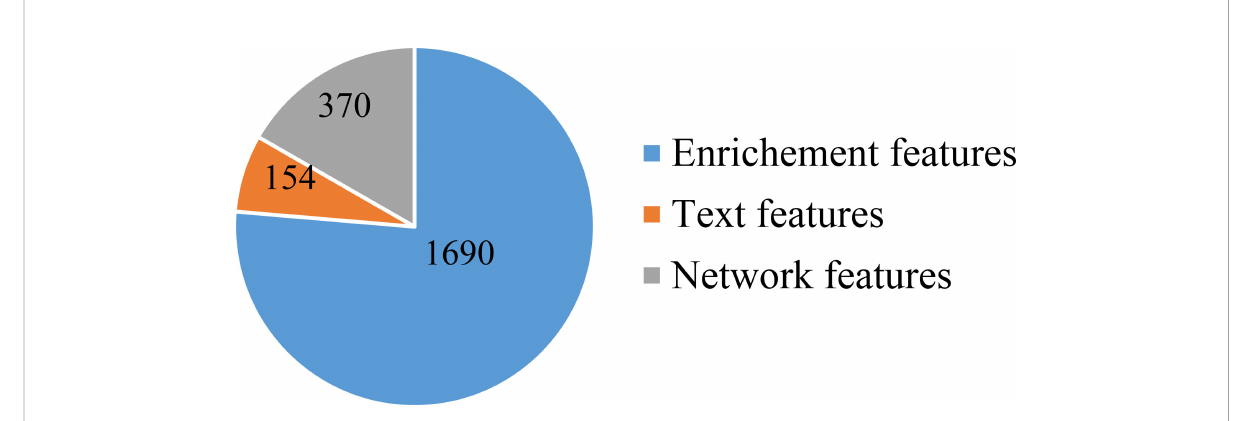
FIGURE 2 Pie chart to show the distribution of features selected by Boruta on three feature types. Enrichment features are most, followed by network and text